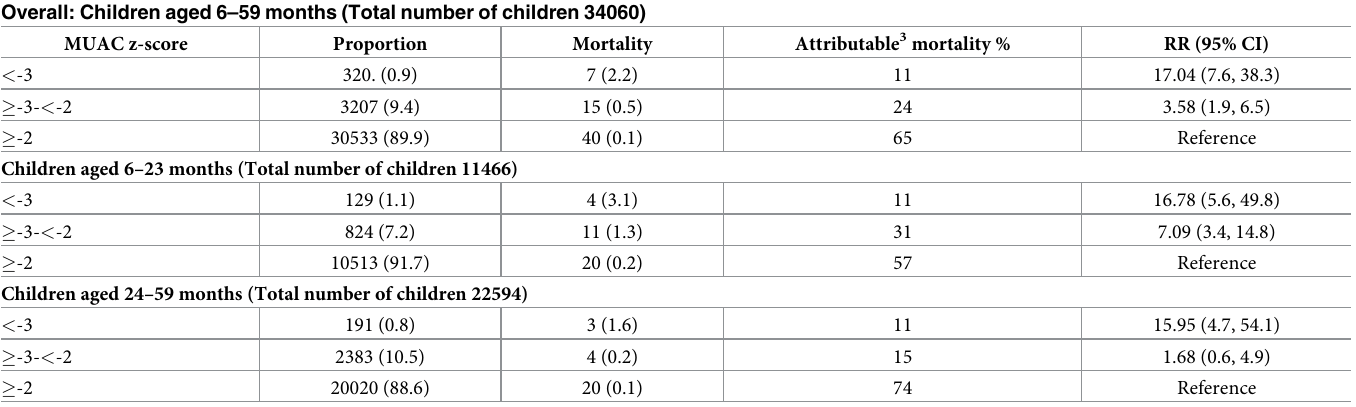
Table 2. Mortality, attributable mortality and risk of mortality in children aged 6–59 months over a 12 month period following initial MUAC measurement by MUAC z-score. Overall: Children aged 6–59 months (Total number of children